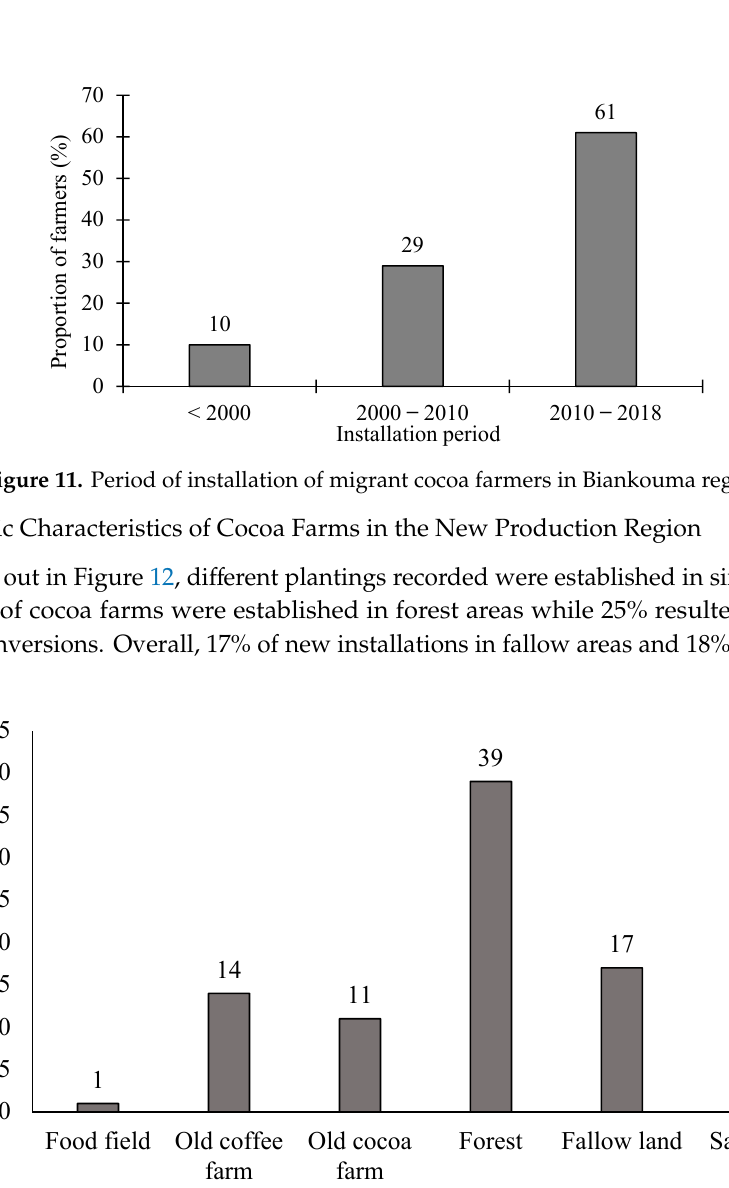
Figure 12. Cultivation history of cocoa farms in Biankouma region.